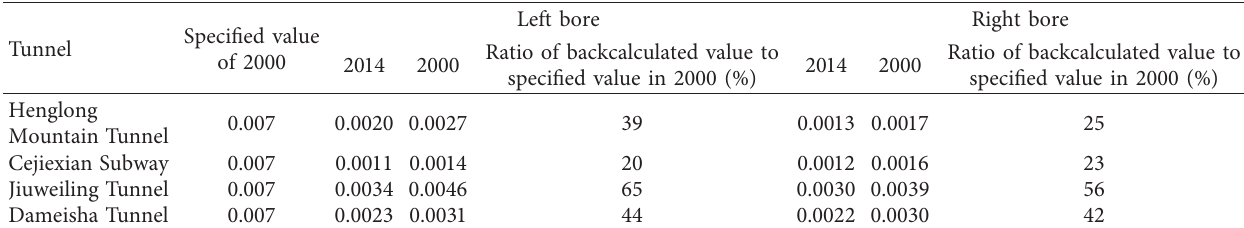
Table 5: The backcalculated CO-based emission factors for different base years (60km/h). Tunnel